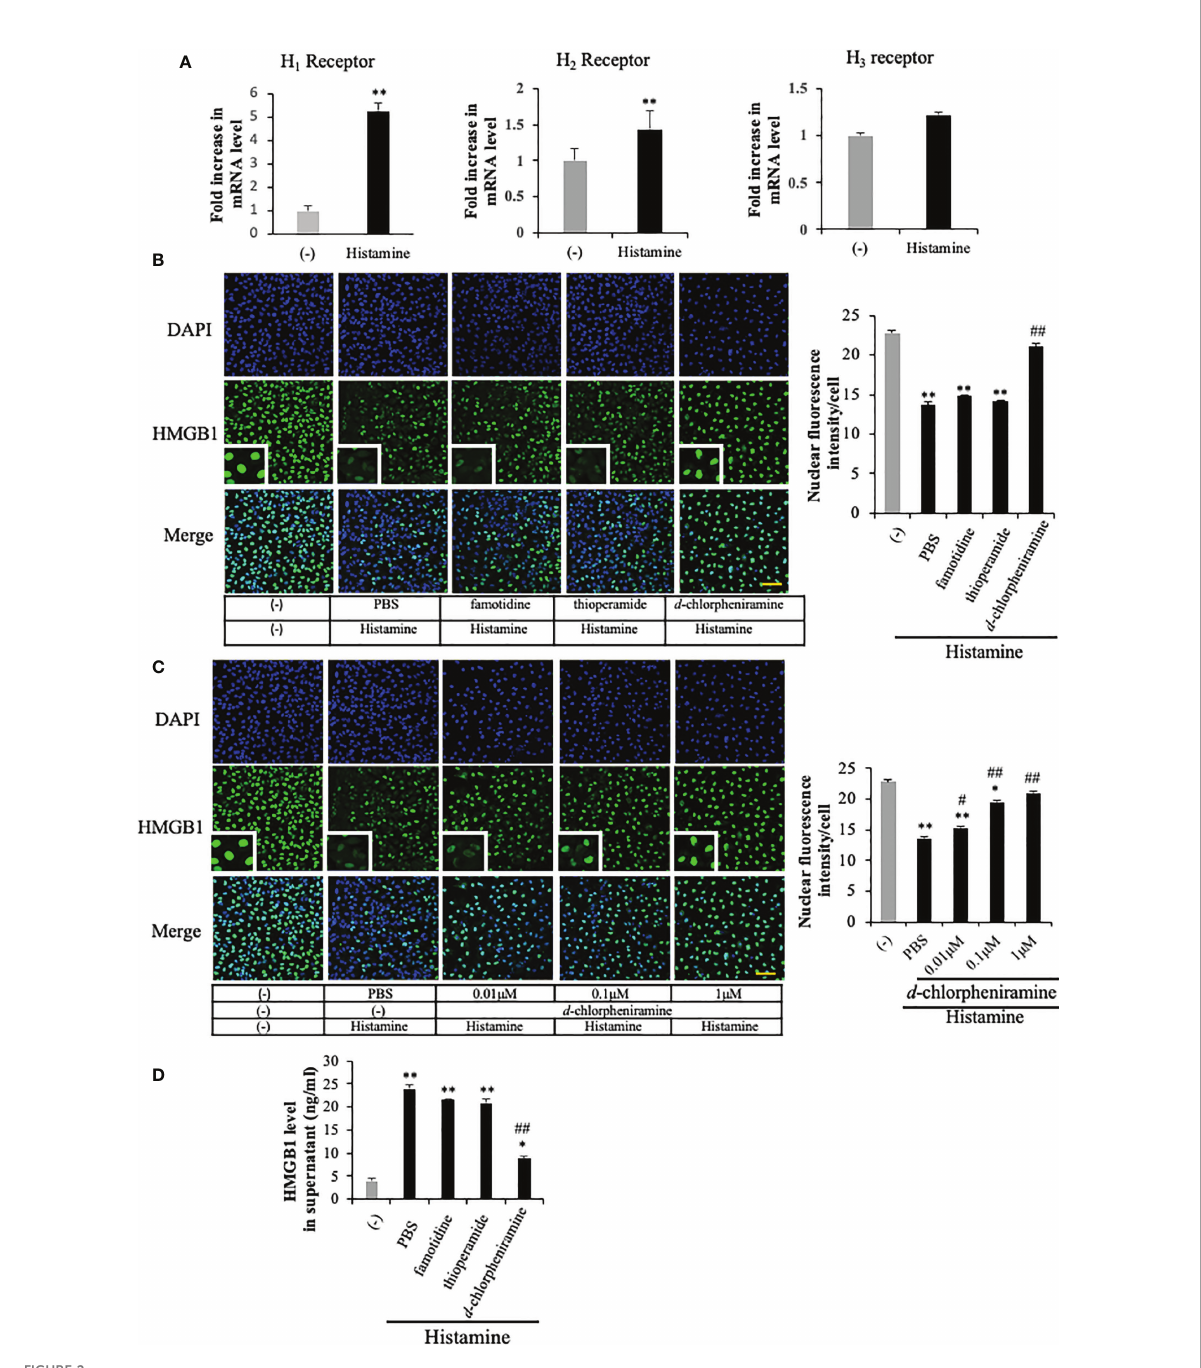
FIGURE 2 The involvement of histamine receptor subtypes in the histamine-induced HMGB1 release in VECs. (A) EA.hy 926 cells were cultured with histamine (1 m M) for 12 h. The mRNA expression of each histamine receptor in the presence or absence of histamine in the cells was measured by quantitative RT-PCR. The results were normalized to the expression of b -actin and are expressed as the mean±SEM (n=5 per group). (B) EA.hy 926 cells were preincubated with each antagonist for 1 h before stimulation with histamine (1 m M). HMGB1 translocation was determined by immunostaining at 12 h after histamine stimulation. Scale bar=10 m m. (C) Different concentrations of d -chloropheniramine were preincubated with the EA.hy 926 cells for 1 h before stimulation with histamine (1 m M) for 12 h. HMGB1 in the cell nucleus is quanti fi ed in the right panel of each group as the means±SEM (n=5 per group). (D) EA.hy 926 cells were preincubated with each antagonist (1 m M) for 1 h. At 12 h after stimulation with histamine (1 m M), the amount of HMGB1 released into the medium was determined. Statistical analyses were conducted by one-way ANOVA followed by the post hoc Fisher test. *p<0.05, **p< 0.01 vs. control in the absence of histamine, # p<0.05, ## p<0.01 vs. histamine-PBS